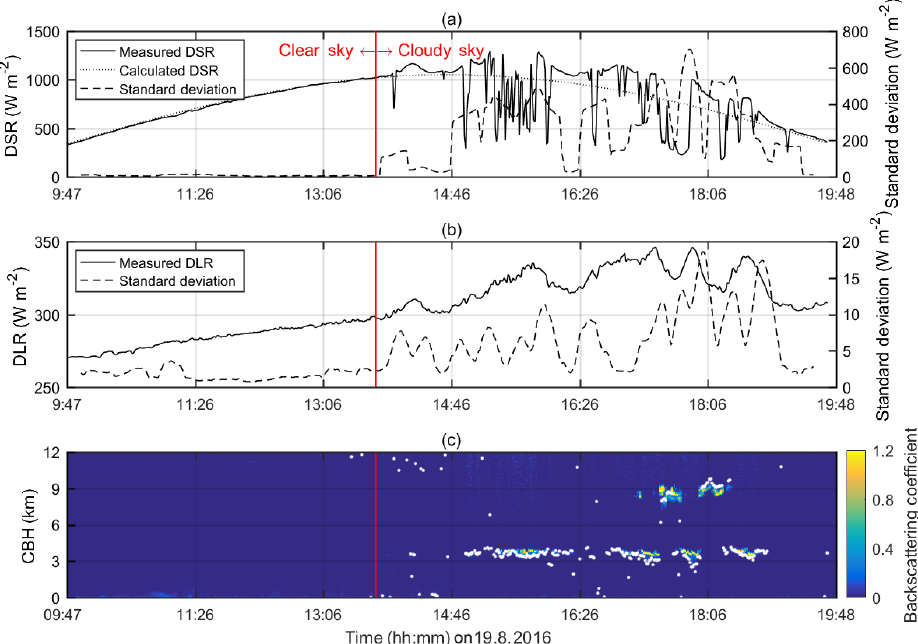
Figure 1. Time series of data sample on 19 August 2016 (time given is local time) transiting from clear sky to cloudy sky: (a) measured (black line) and calculated (dotted black line) downward shortwave radiation and its 21min standard deviation (grey line), (b) measured downward longwave radiation and 21min standard deviation, and (c) MPL backscattering coefficient and the cloud base height.